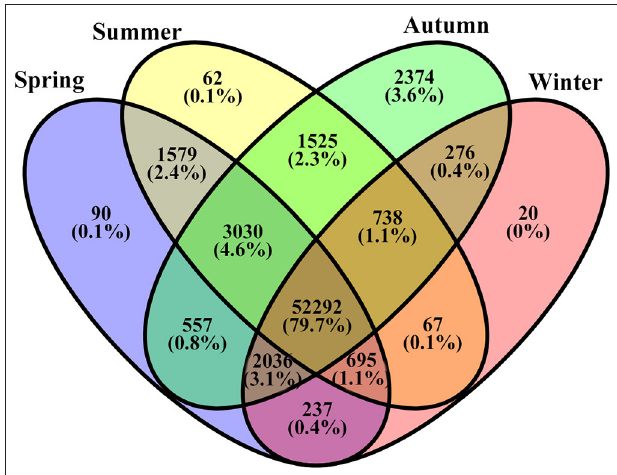
FIGURE 3 | A Venn diagram of unigenes commonly and uniquely distributed in different seasonal FD-TRs in T. hemsleyanum